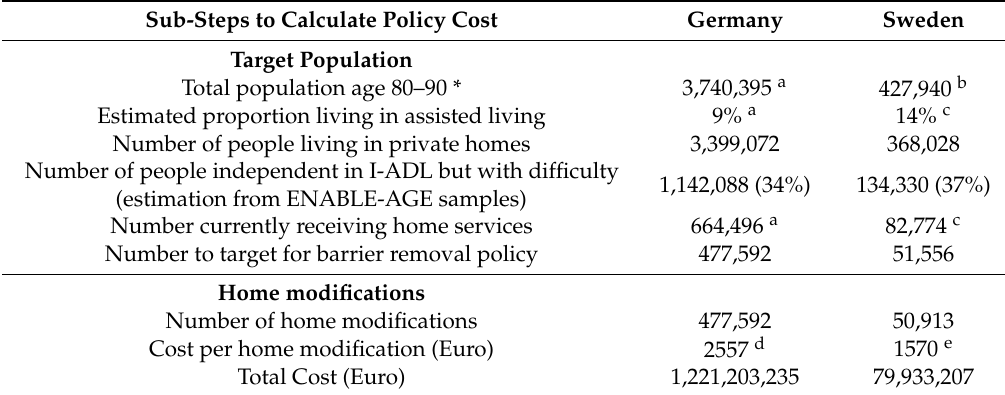
Table 3. Step 4: estimating the population to target for intervention and the costs to implement the barrier removal